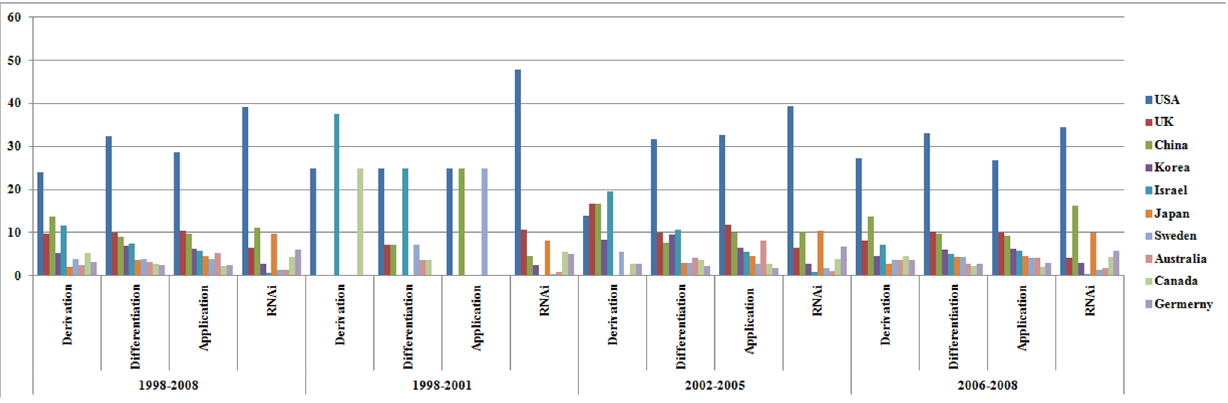
Figure 2. Percentage in Three hESC Research Subfields. As Figure 1, top 10 countries were included in terms of percentage in hESC research. Y axis indicates percentage (%).